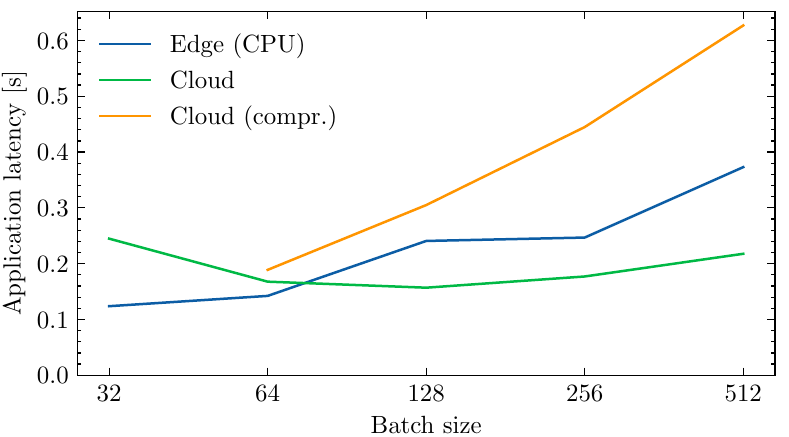
Figure 5. The mean application latency shows the mean time required to estimate BP from a batch of ECG samples and store the result in the cloud.